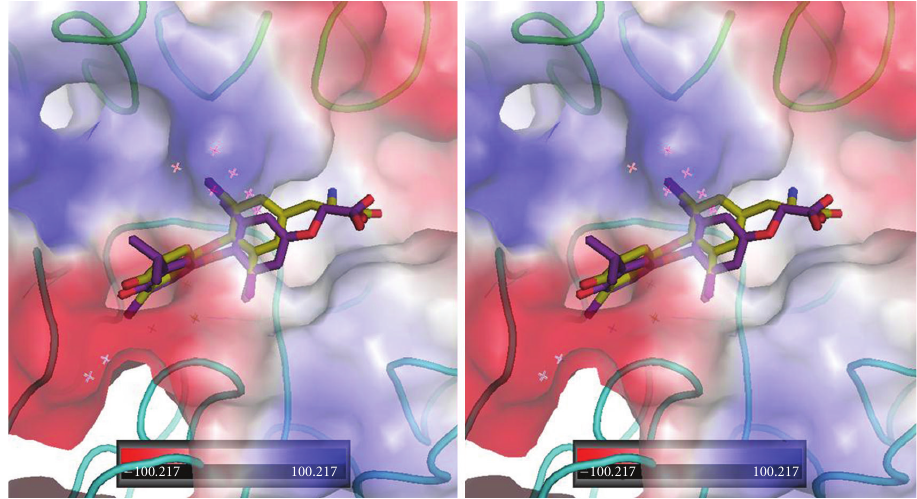
Figure 9: Stereoview of α v β 3 integrin RGD electrostatic surface showing GC-1 (violet) and T 3 (gold, Ca2) near the RGD binding